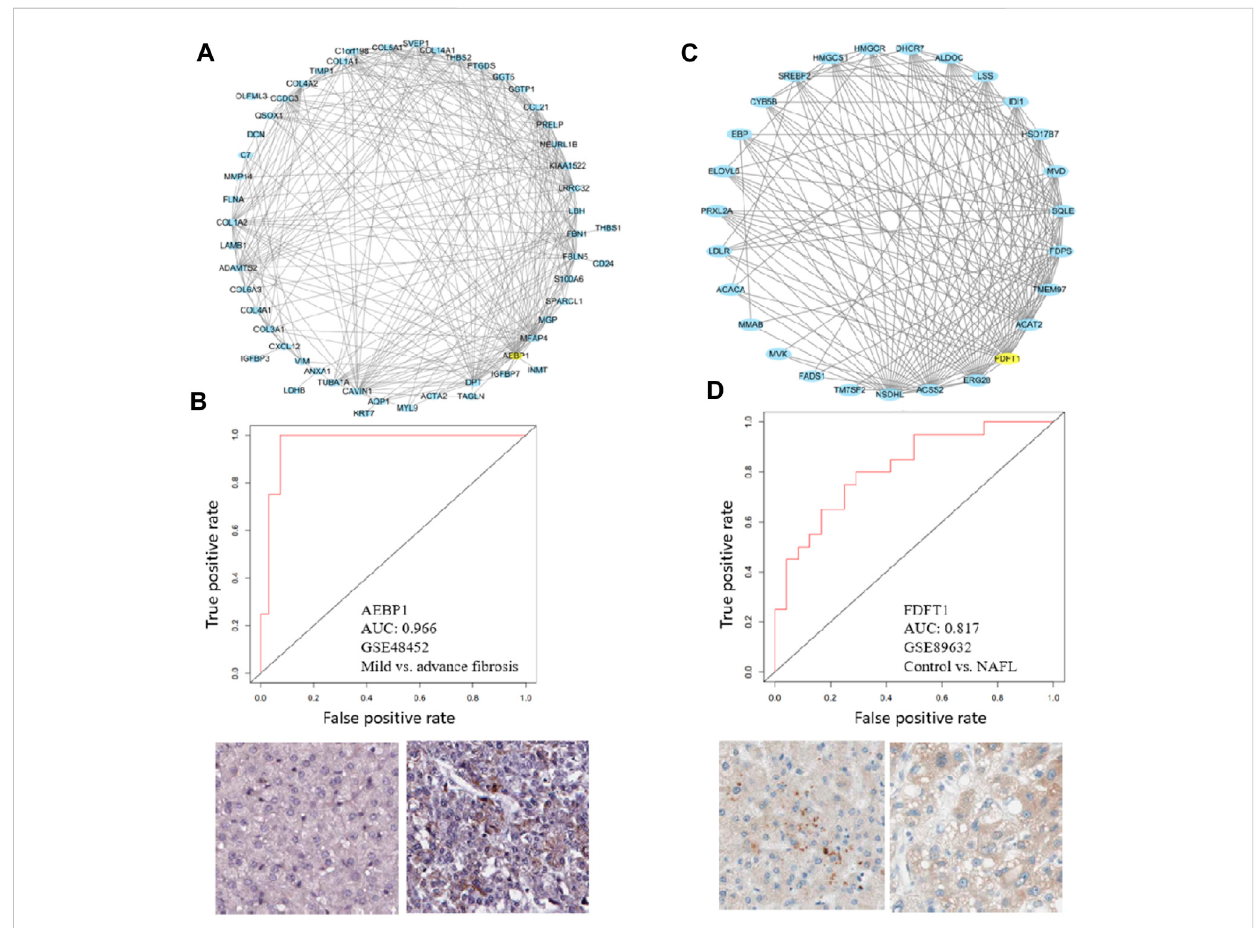
FIGURE 8 Hub genes in M25 and M39 can separate patients. (A, C) Module visualization for the top 100 connections within M25 and M27 by using Cytoscape. Yellownodesindicatethehubgeneofmodules (B,D) ROCcurvesshowthathubgenesofM25andM39, Aebp1 ,and Fdft1 canseparateadvanced fi brosis or NAFL patients. Immunohistochemical plots also show the positive staining of AEBP1 and FDFT1 in normal and HCC